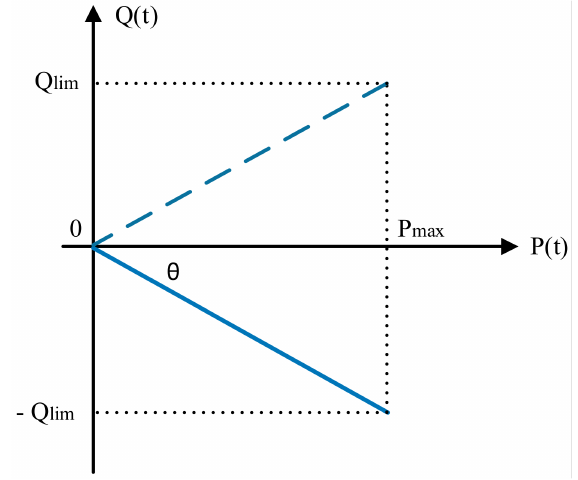
Figure 2. Fixed power factor